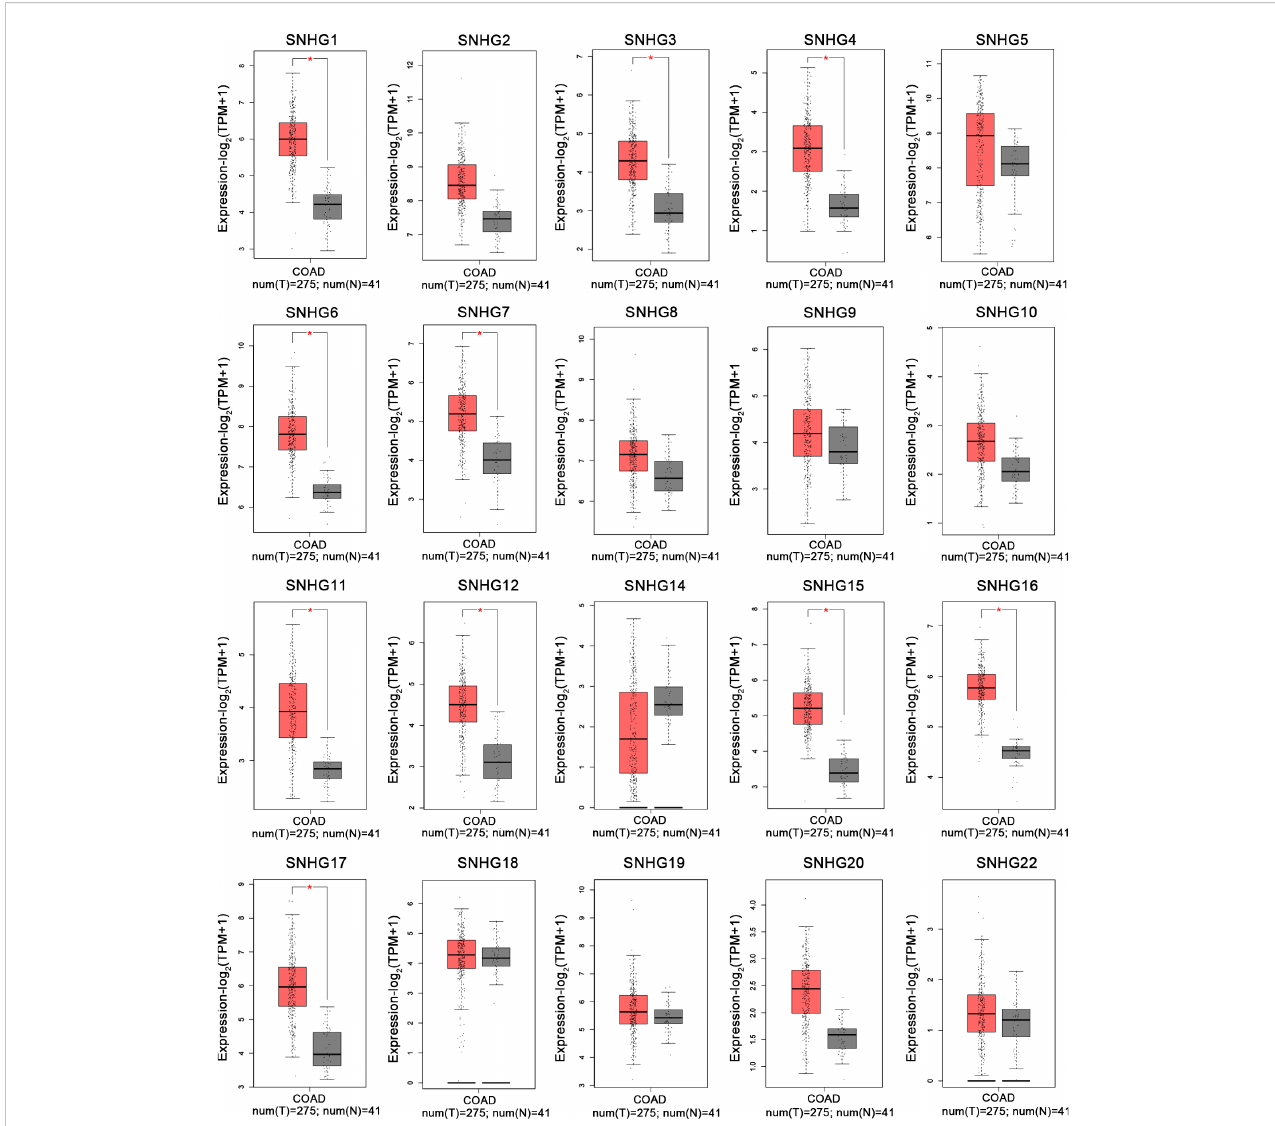
FIGURE 10 Expression levels of SNHG1-SNHG22 in colonic tumor and normal tissues in the GEPIA cohort by merging SNHG expression data